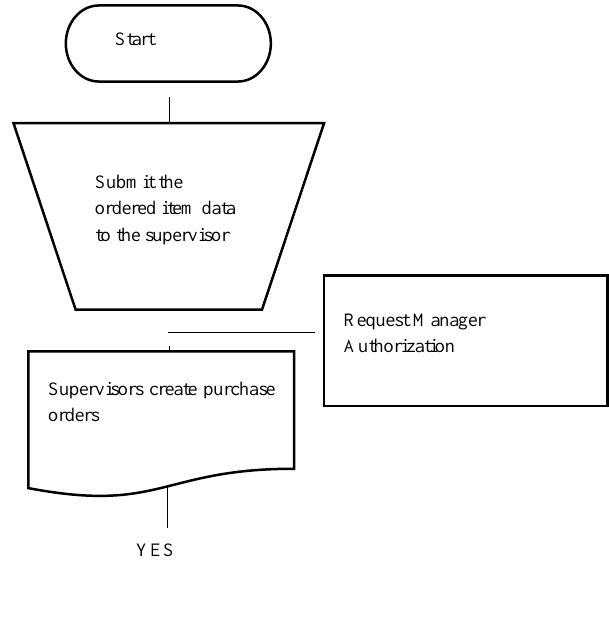
Figure 1: Flowchart Procedure for Purchase of Inventory